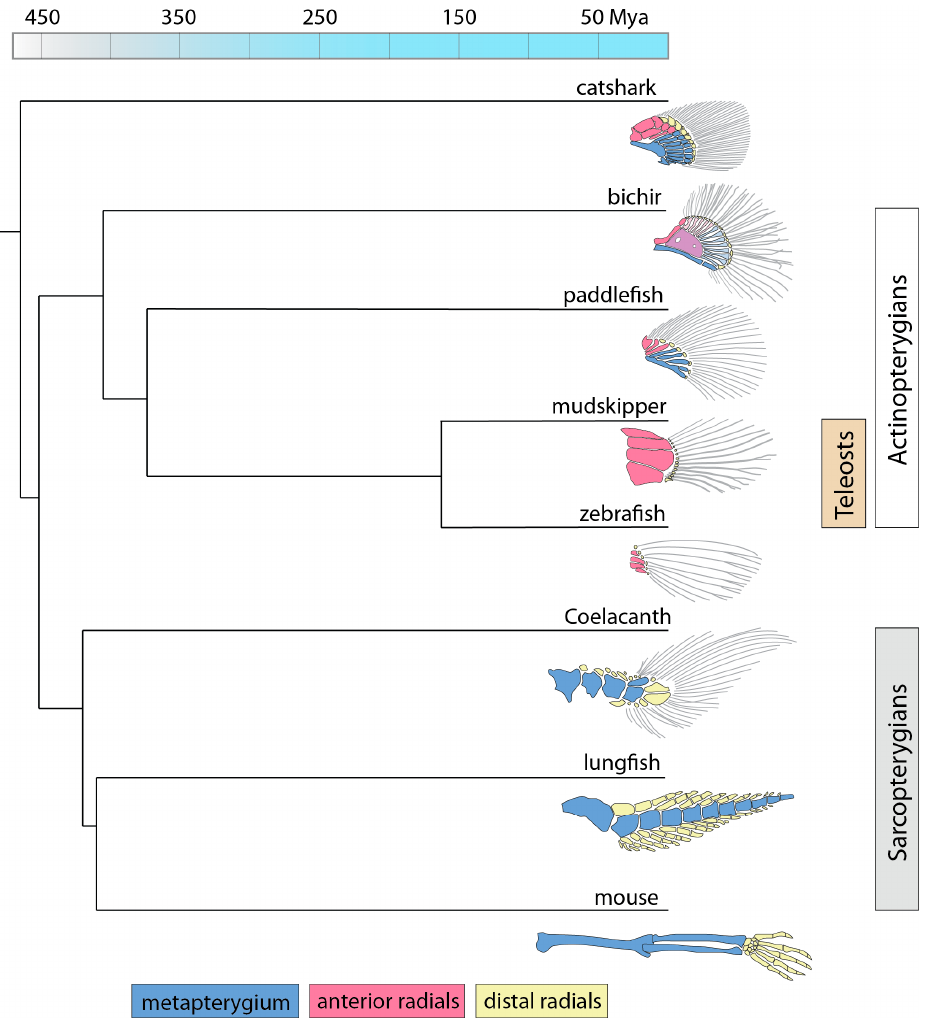
(Figure 2d). The regenerated pectoral fins had a heteromorphic character, the exoskeletal fin rays always being smaller (21 / 26) and often taking a twisted shape (5 / 26) (Figure 2d–f). In 5 / 26 cases, we did not observe regeneration at all. Interestingly, whenever regeneration occurred, we could observe distinct regenerated structures as soon as 2 weeks post-amputation (wpa)—the time-frame for normal exoskeletal regeneration in this species. Conversely, if by 2 wpa, no regenerated tissue formed and tissue formed and regeneration was not observed at all during our 6-weeks observation period regeneration was not observed at all during our 6-weeks observation period (Figure A1a,b). (Figure A1a,b).